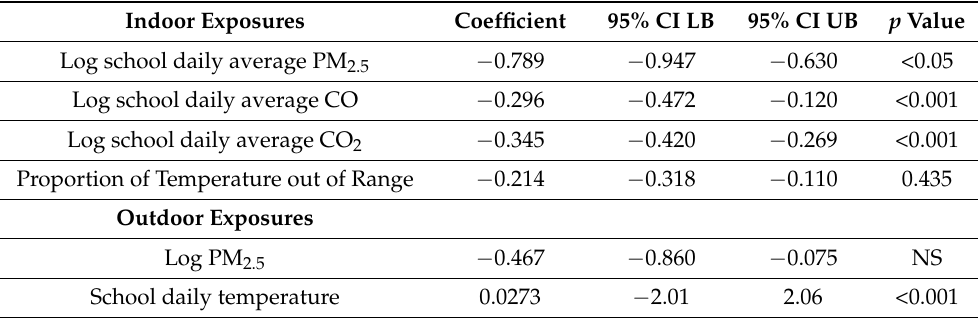
Table 3. Linear mixed models comparing indoor air quality within seven schools with pre- and post-renovation monitoring data.